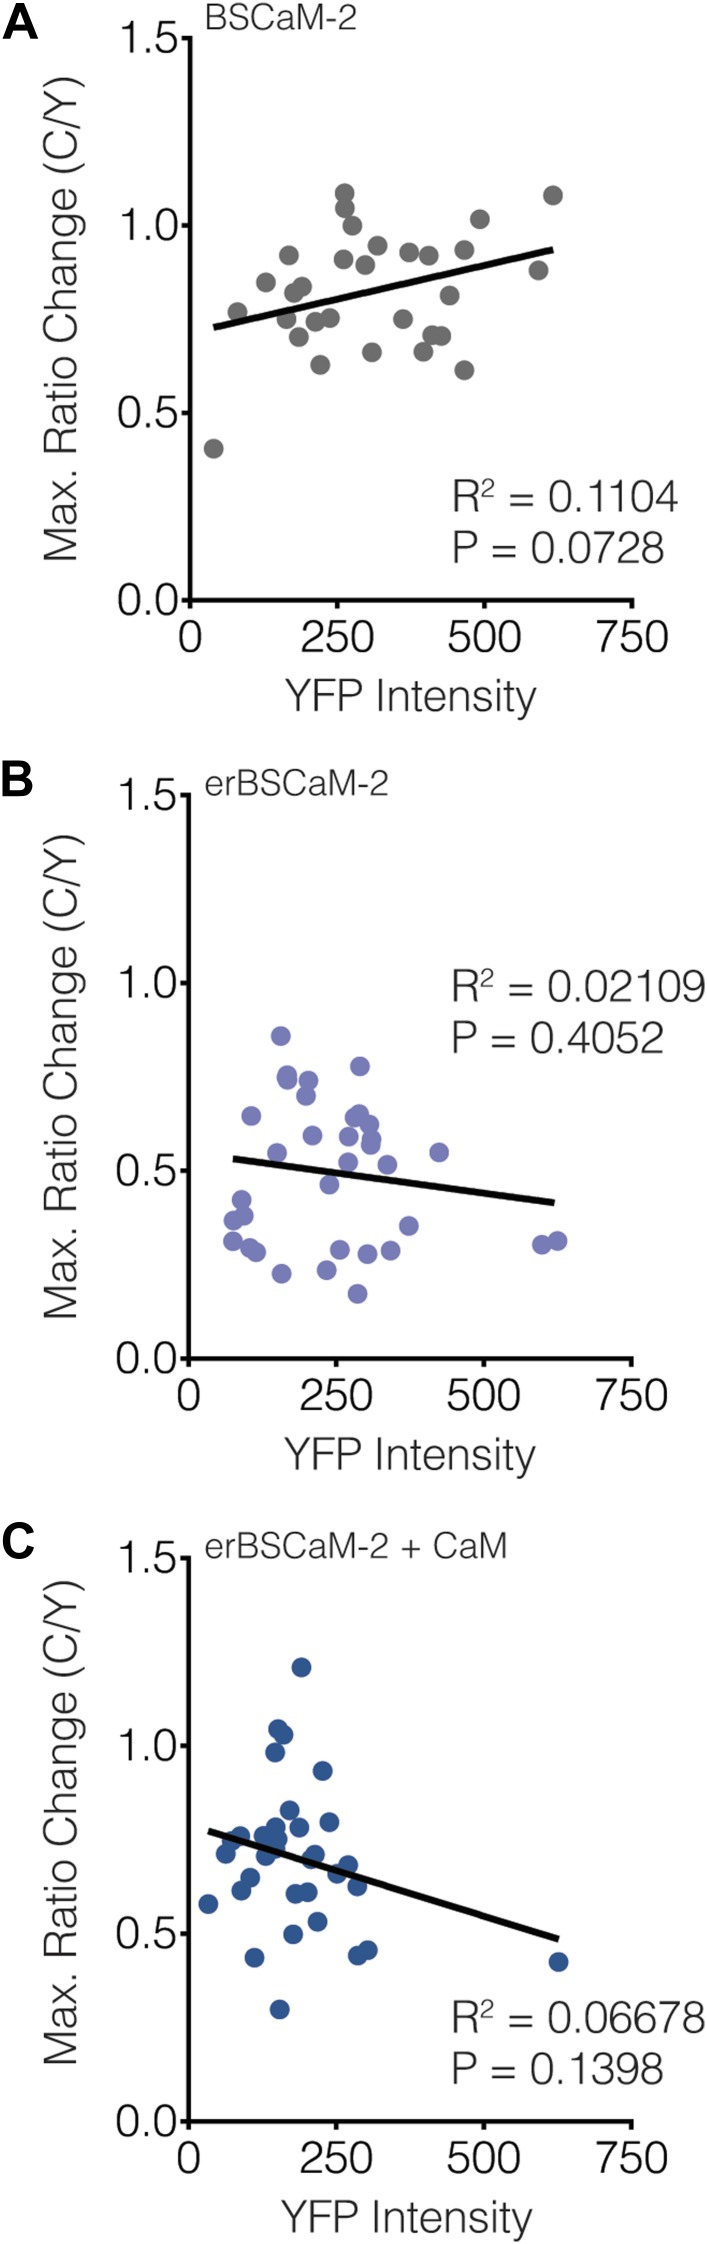
Subcellular BSCaM-2 responses are not affected by the reporter expression level.Scatter plots showing the maximum C/Y FRET ratio change vs YFP intensity (i.e., reporter expression level) for (A) BSCaM-2, (B) erBSCaM-2, and (C) erBSCaM-2 + CaM, which correspond to ‘Cyto’, ‘ER’, and ‘ER+CaM’ in Figure 9B. Very weak positive or negative correlations were detected using linear regression analyses, though none of the correlations were statistically significant.